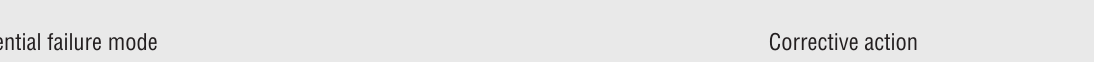
Potential failure